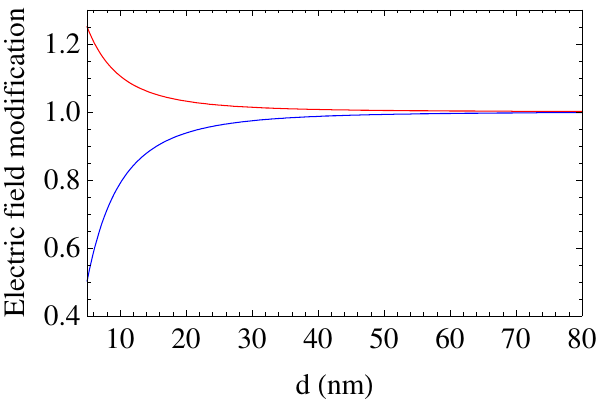
Figure 8. (Color online) The variation in the electric-field modulation term | l ( ω 21 , d ) | as a function of distance d for a z -polarized electric field (blue curve) and x -polarized electric field (red